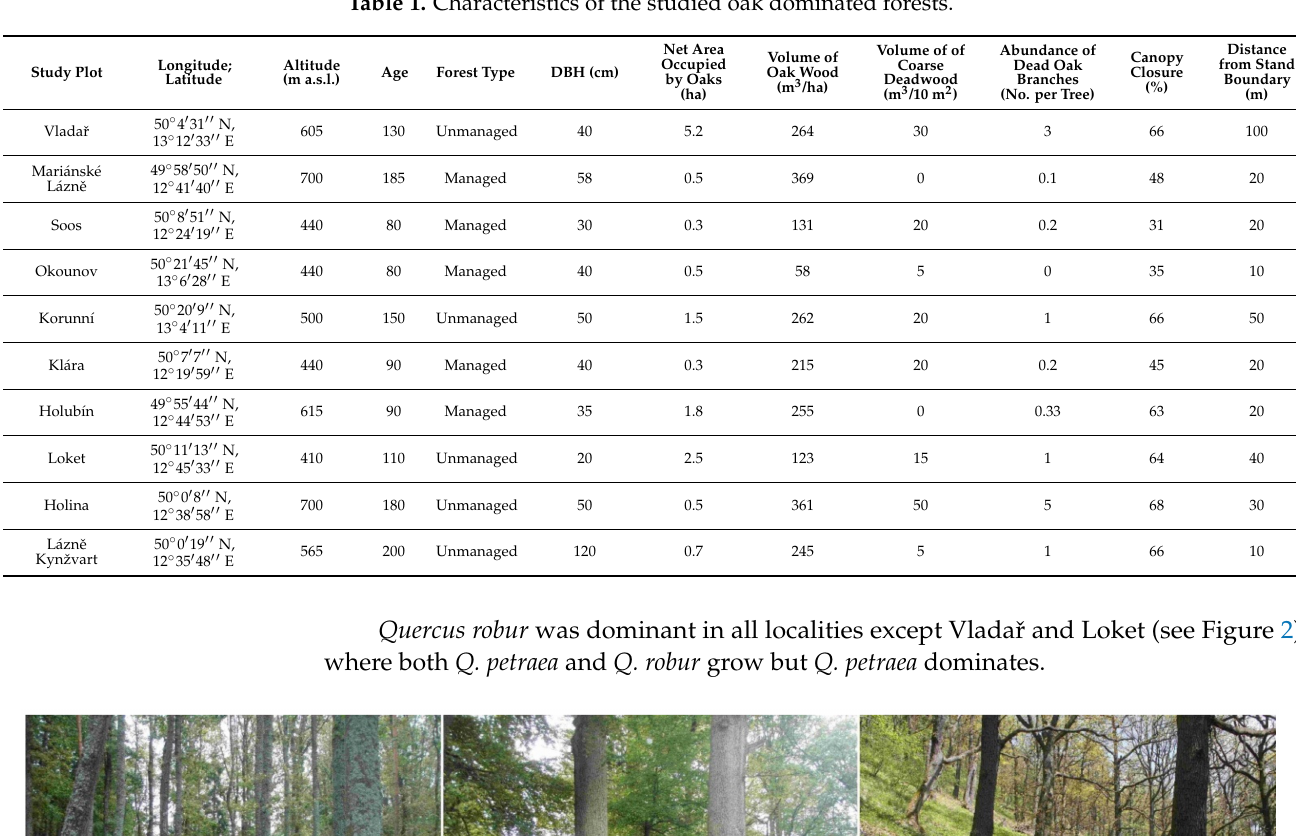
Table 1. Characteristics of the studied oak dominated forests.